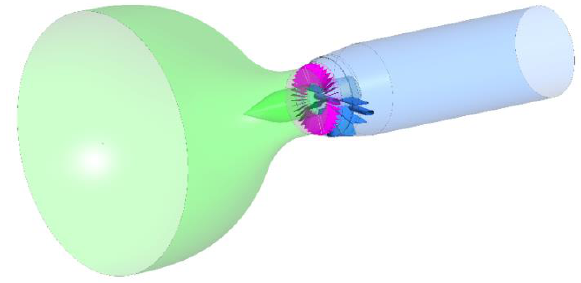
Fig. 5. Numerical model (the inlet part – green, the middle part – pink, the outlet part – blue).